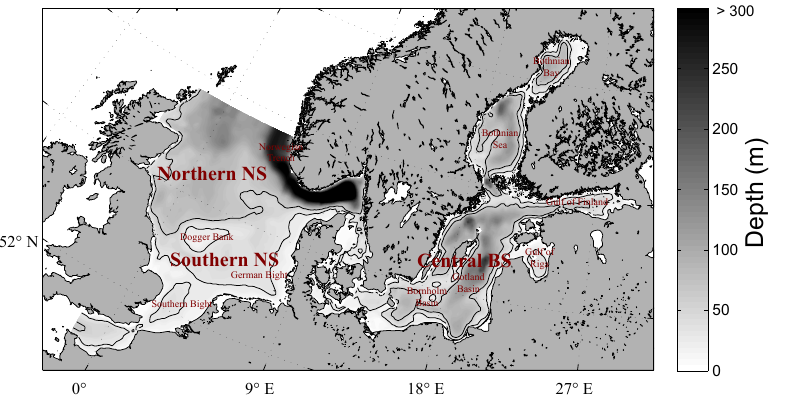
Figure 1. Model area and bathymetry. Black lines indicate the 30 and 60m depth lines (the 60m depth line separates the northern and southern North Sea; central BS includes all areas east of 14 ◦ E excluding the gulf regions).